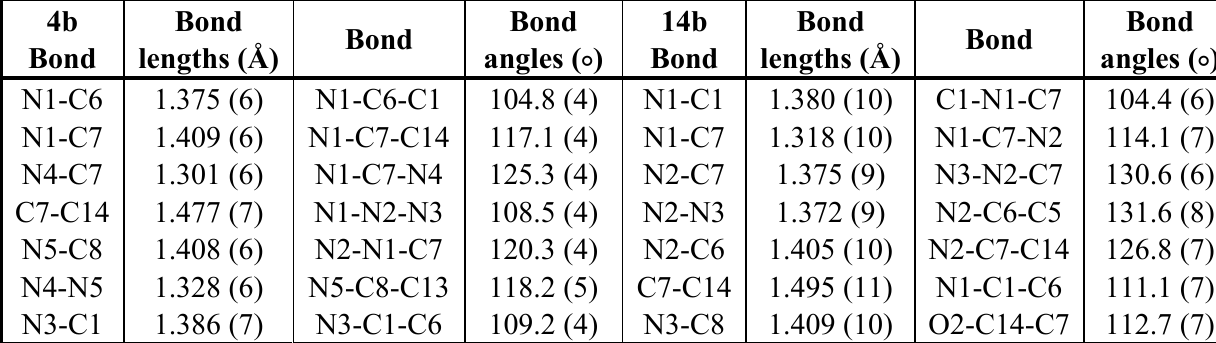
Table 2. Selected bond lengths and bond angles for compounds 4b and 14b